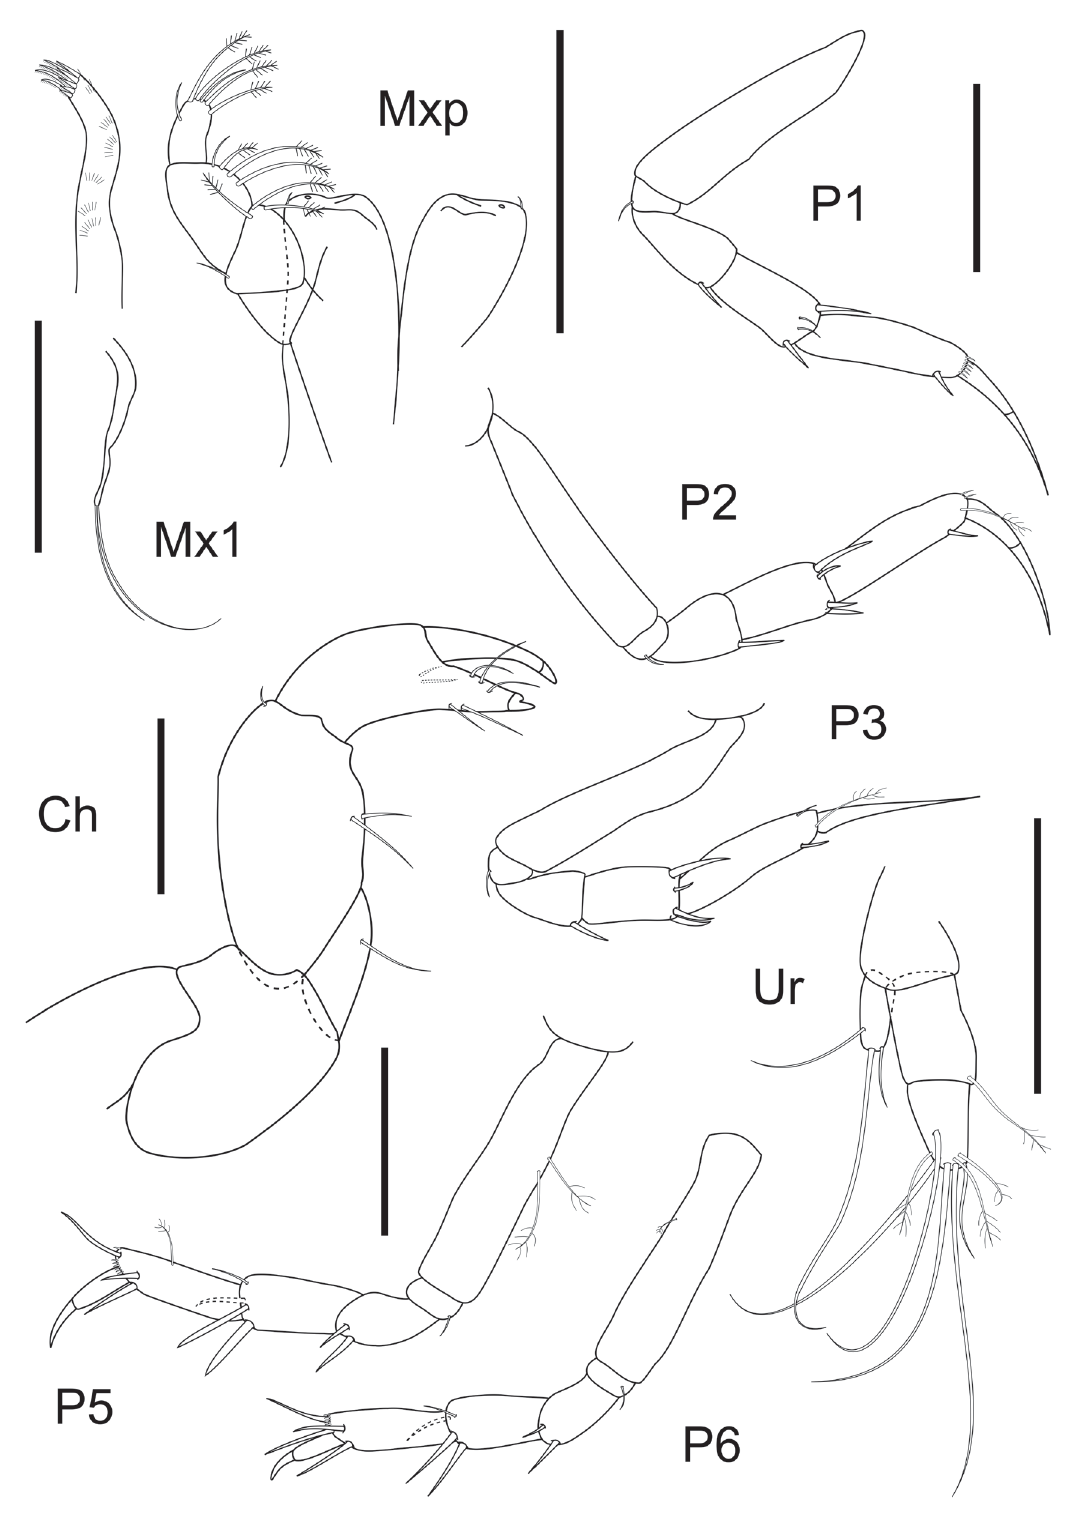
Fig. 5. Macrinella lavradoae sp. nov., holotype, ♀ (MNRJ 24445), length 1.9 mm. Abbreviations: Mx1 = maxilulle; Mxp = maxilliped; Che = cheliped; P1 = pereopod 1; P2 = pereopod 2; P3 = pereopod 3; P5 = pereopod 5; P6 = pereopod 6; Ur = uropod. Scale bars =